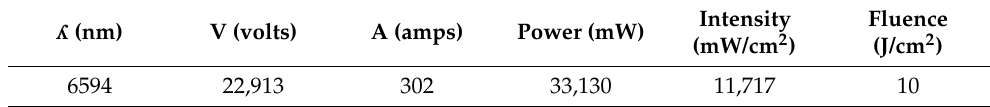
Table 1. LED well plate illuminator